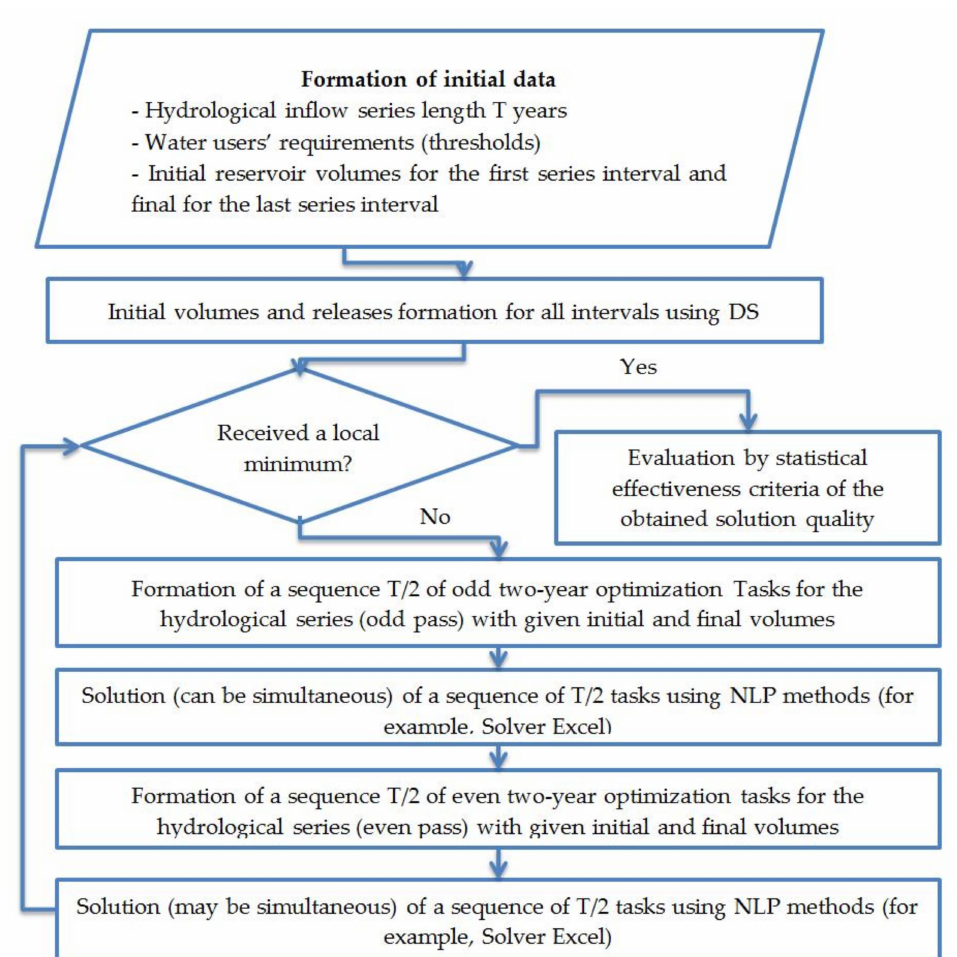
Figure 3. The algorithm flowchart of optimal releases for solving a reservoir